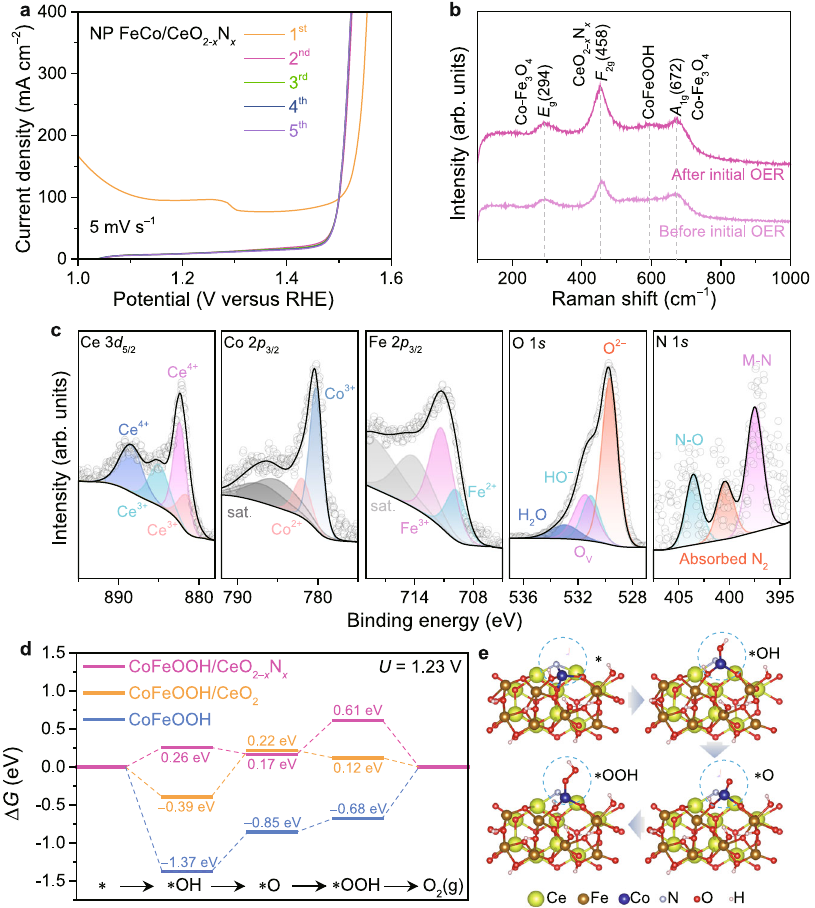
Fig. 2 | Surface reconstruction of composite electrode. a Typical initial fi ve OER polarization curves ofnanoporous (NP) FeCo/CeO 2 − x N x composite electrode. Scan rate: 5mVs − 1 . b Raman spectra of NP FeCo/CeO 2 − x N x composite electrode before (light pink) and after (dark pink) initial six OER polarization curves in 1M KOH aqueous electrolyte. c High-resolution XPSspectraof Ce 3 d 5/2 , Co 2 p 3/2 , Fe2 p 3/2 , O